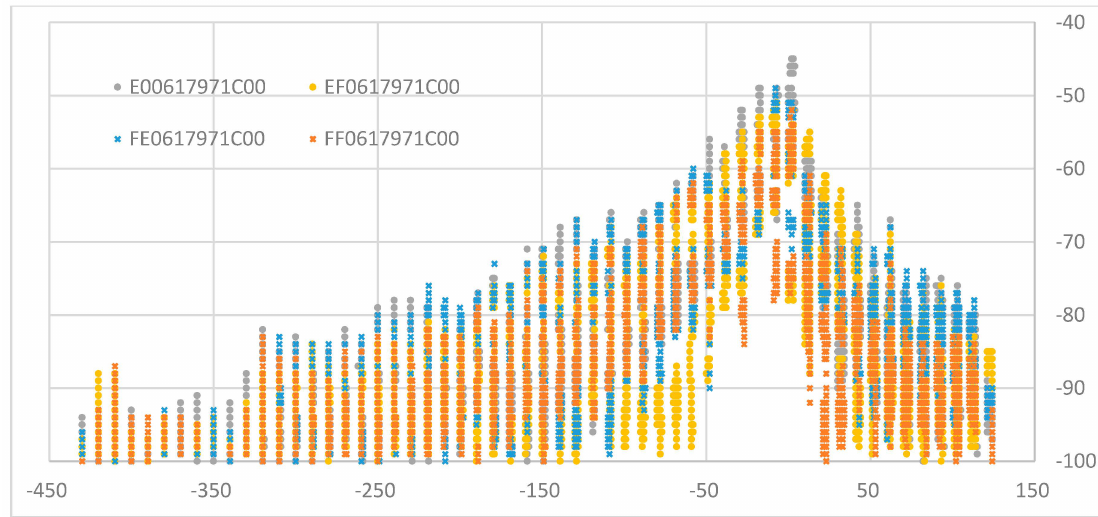
Figure A2. Static experiment test with four BLE Tags on the